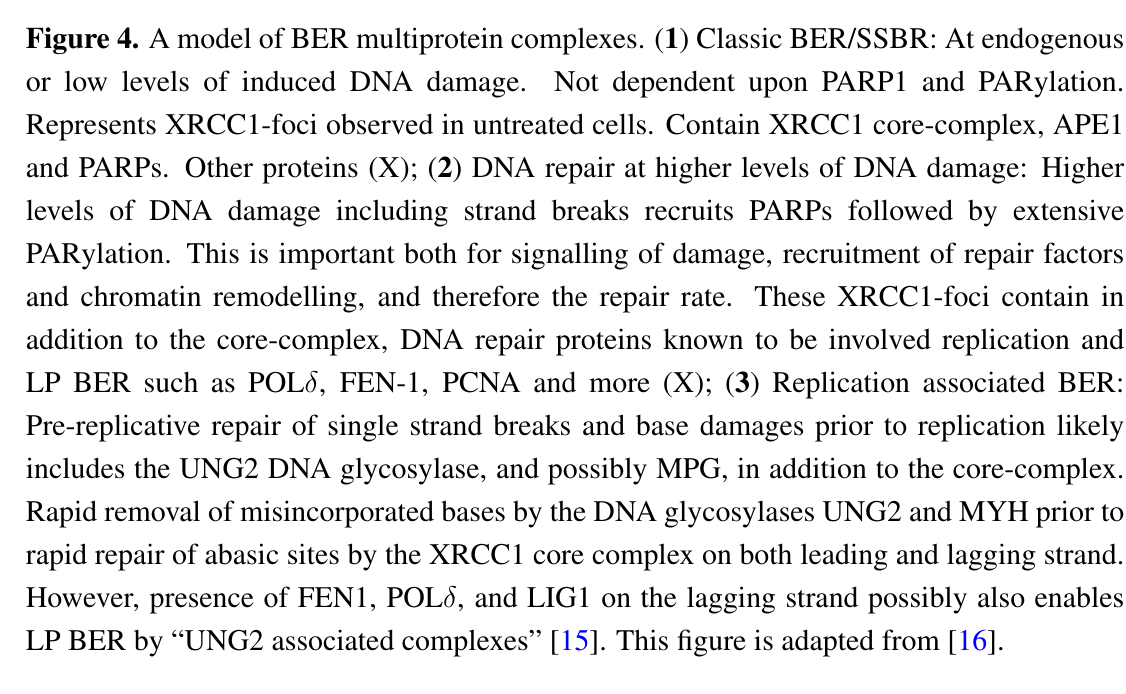
Figure 4. A model of BER multiprotein complexes. ( 1 ) Classic BER/SSBR: At endogenous or low levels of induced DNA damage. Not dependent upon PARP1 and